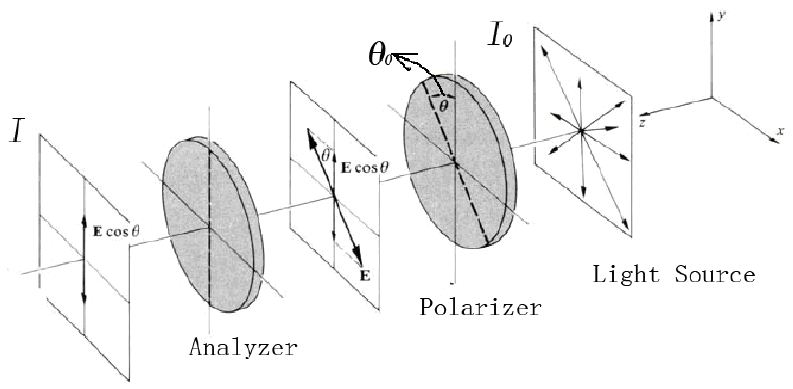
Figure 1. Typical polarized light detecting